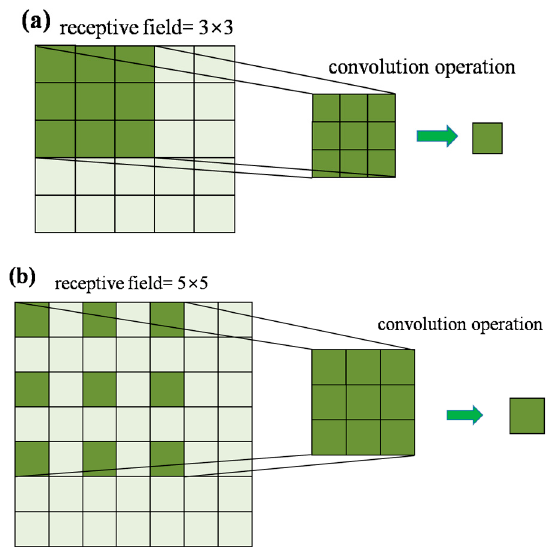
Figure 2. Convolution operation with different dilation factors: ( a ) d = 1 and ( b ) d = 2.